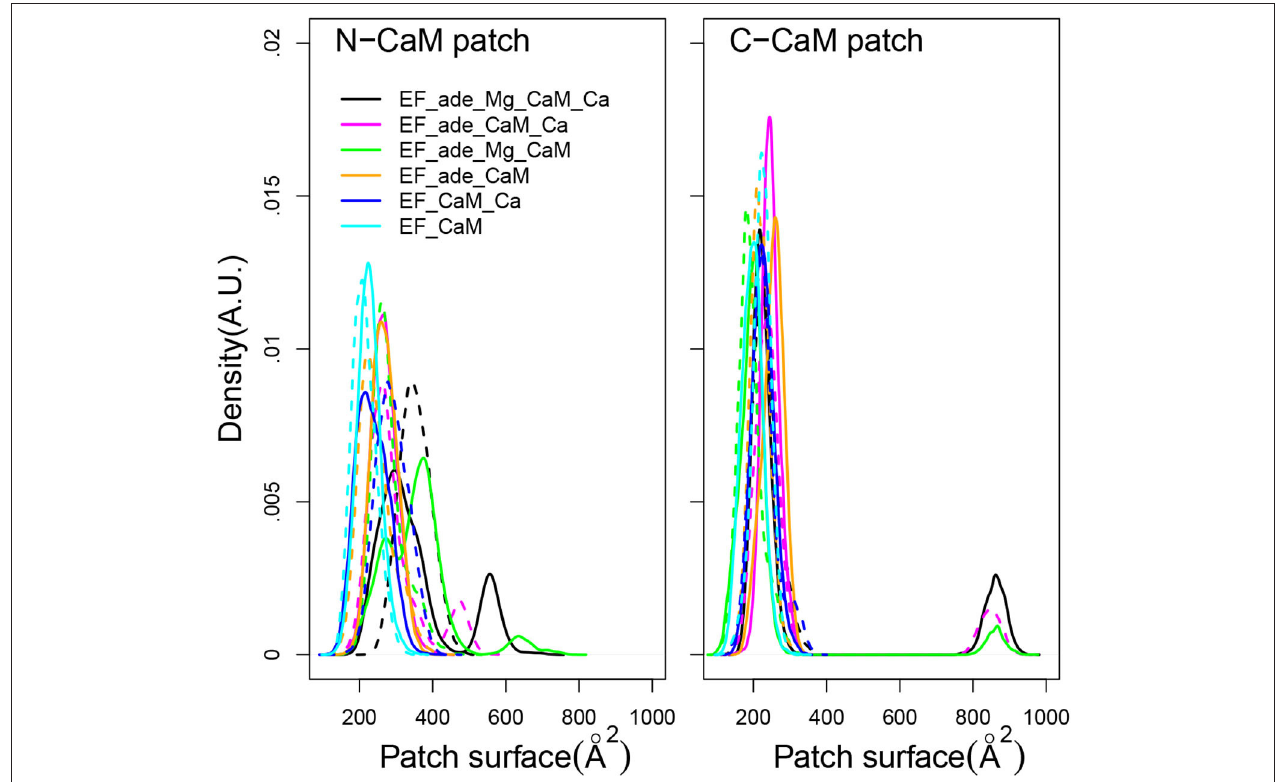
FIGURE 5 | Distribution of accessible surface (Å 2 ) of the hydrophobic patch of N-CaM and C-CaM. The N-CaM patch is defined by the residues A10, F12, A15, L18, F19, L32, M36, L39, M51, V55, M71, M72, M76. The C-CaM patch is defined by the residues I85, A88, V91, F92, L105, M109, L112, L116, M124, F141, M144, M145, A147. For each trajectory, the plain and dashed curves correspond to replicas R1 and R2.